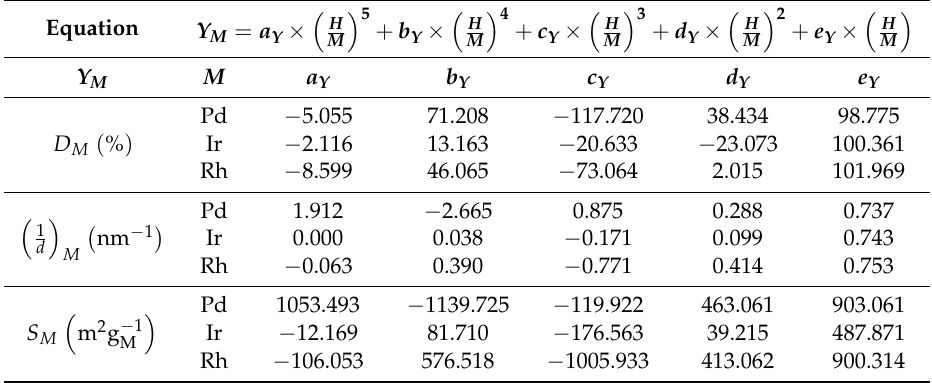
Table 4. Values of the constants a Y , b Y , c Y , d Y , and e Y for Equation (11). ( M : metal; range of validity